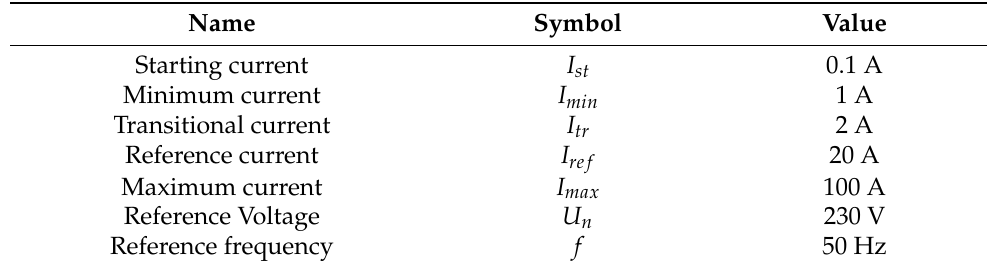
Table 5. Definitions of meter